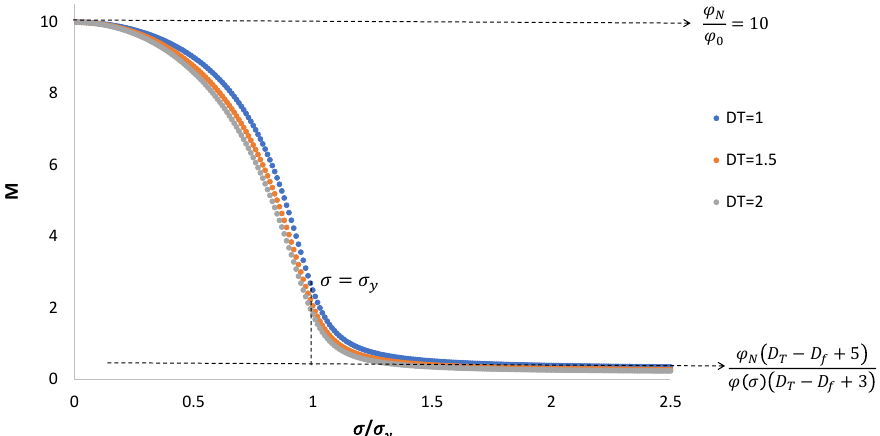
Figure 2. Mobility ratio as a function of applied stress. For small stresses, the relative mobility is = 10. For high stresses, the relative mobility is M ( σ → ∞ ) = K 2 M ( σ → 0 ) = ϕ N ϕ 0 plateau stress, M = K 2 K 3